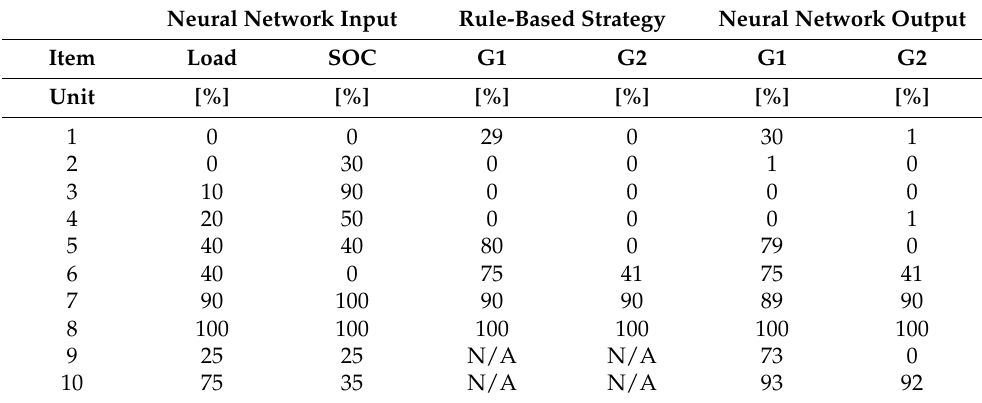
Table 3. Results of neural network outputs based on neural network inputs of proposed generator– battery hybrid system.